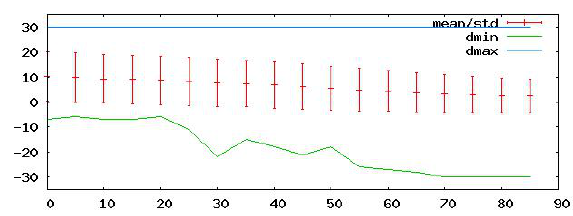
Figure 10: Statistics of errors using inverse distance weighted in- terpolation on synthetical urban DSMs, occluded (elevation 60 ◦ ) with increasing hole probability from 0 % to 85 %, minimum (green), maximum (blue) deviation and mean and standard devi- ation (red) to original reference DSM